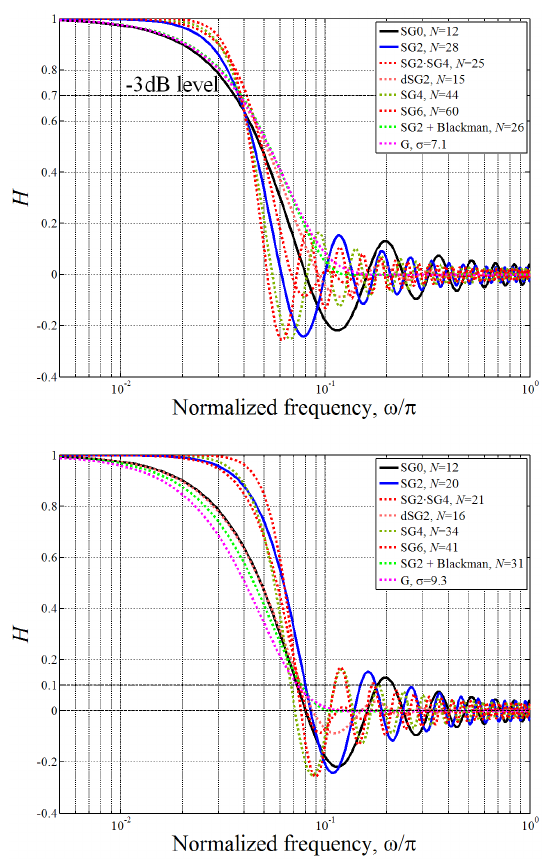
Figure 13. Upper panel: frequency responses of different low-pass filters with the same ERes ( = 25 (cid:49)R raw ) estimated using the NRR criterion. The curves show similar behavior at lower frequencies and have nearly the same cut-off frequency ω c = ω | H tom panel: the same curves as in the upper panel, but with the ERes ( = 25 (cid:49)R raw ) calculated using the Rayleigh criterion. In this latter case, the common feature of the frequency responses curves is the extension of the stop-band region. H ≈ 1 for 0 <ω/π< 4 × 10 − 3 for all the